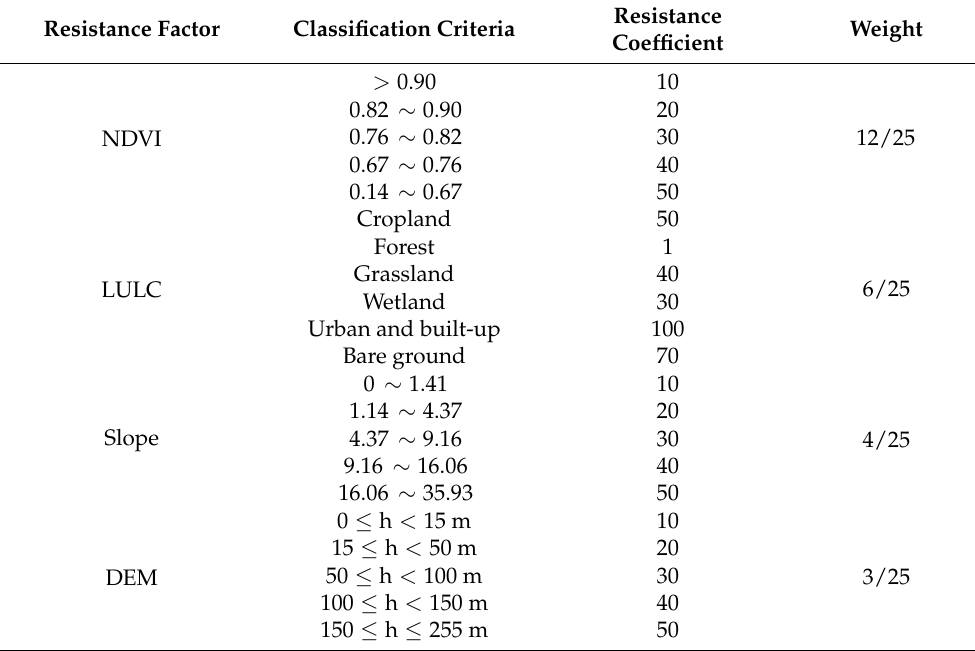
Table 4. Integrated resistance surface parameter setting in the study area. Resistance Factor Classification